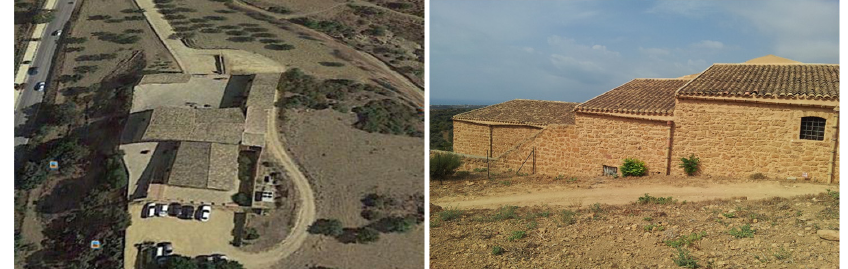
Figure 1. Images of the Sanfilippo House.